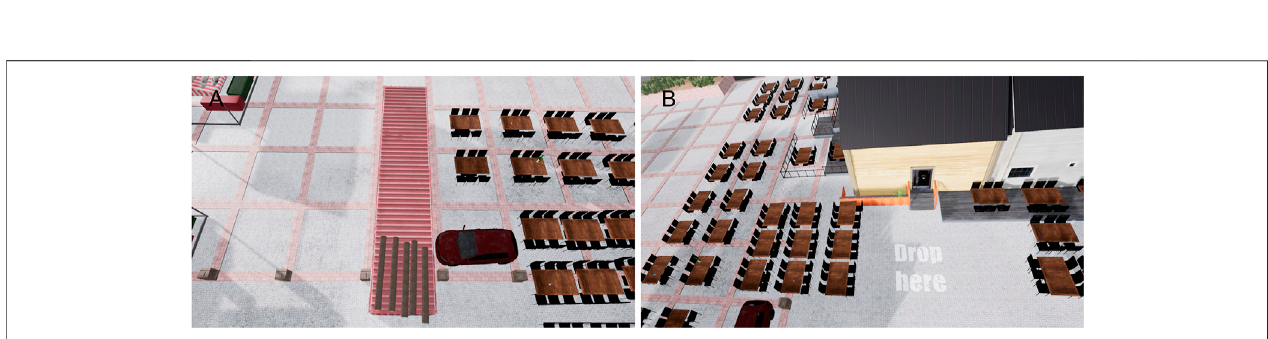
FIGURE 6 | The container with the logs as seen in the beginning of the experiment (A) and the area in which the fi rst three logs were to be dropped (B)